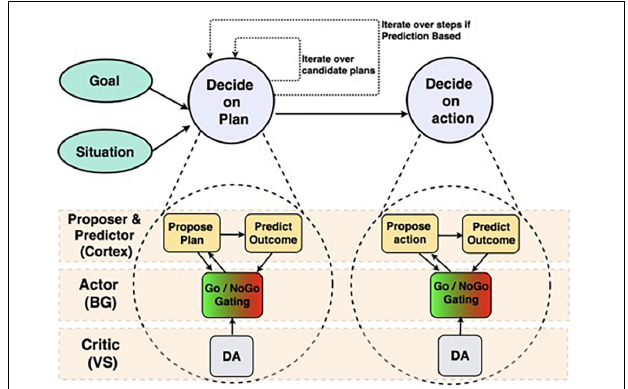
FIGURE 1 | Structure of Proposer-Predictor-Actor-Critic architecture (Herd et al., 2019) across frontal cortex and subcortical areas. We depict two parallel circuits with a hierarchical relationship. The top is a broad functional diagram, emphasizing the serially iterative and hierarchical nature of our proposed decision-making process. The bottom expands those functions, and identifies the brain areas that perform each function.